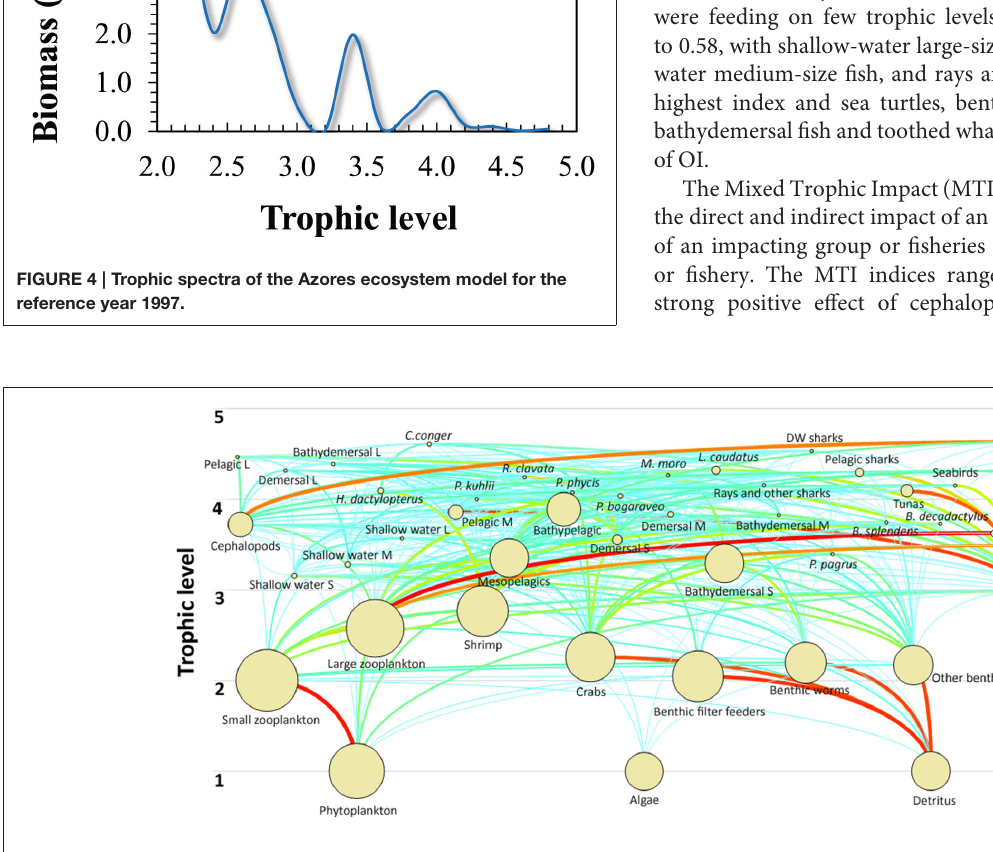
Frontiers in Marine Science |